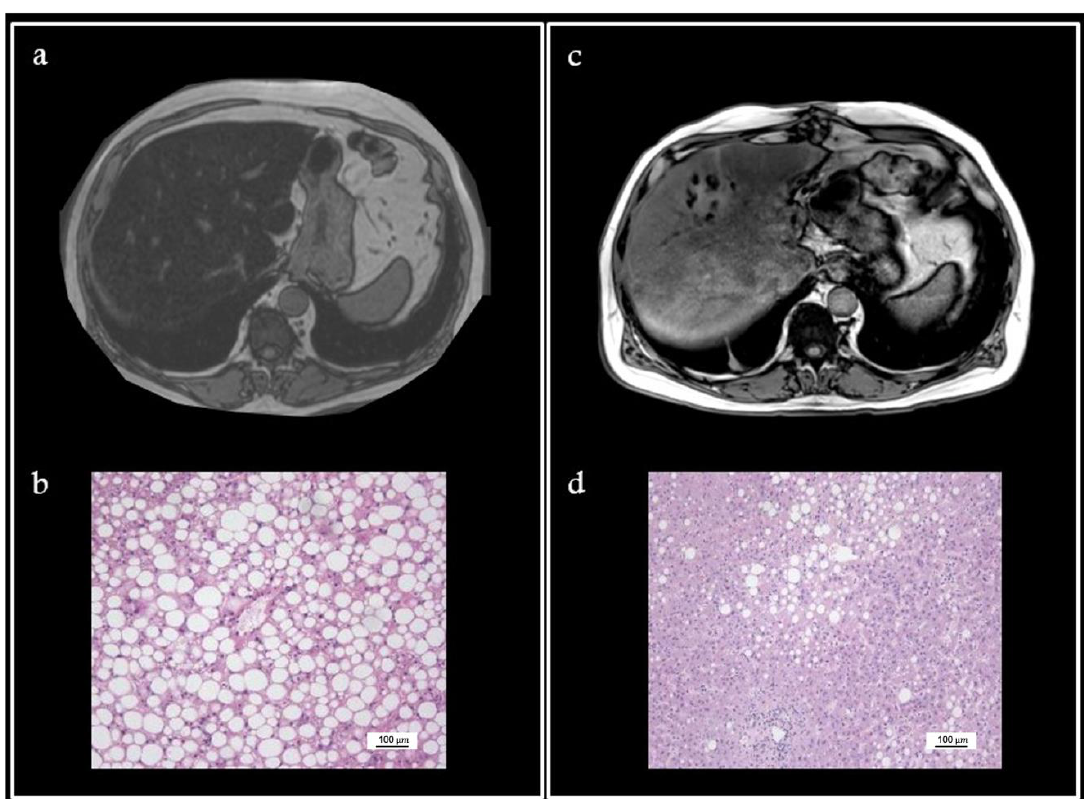
Figure 1. Preoperative MRI (T1-weighted) showed important steatosis ( a ). Liver biopsy confirmed 90% macrovacuolar steatosis (( b )-H&E). New MRI (T1-weighted) performed 3 weeks after the hypocaloric hyper-protein diet demonstrated a decrease in the fat liver content ( c ), with vacuolar steatosis decreased to 30% on histology (( d )-H&E).